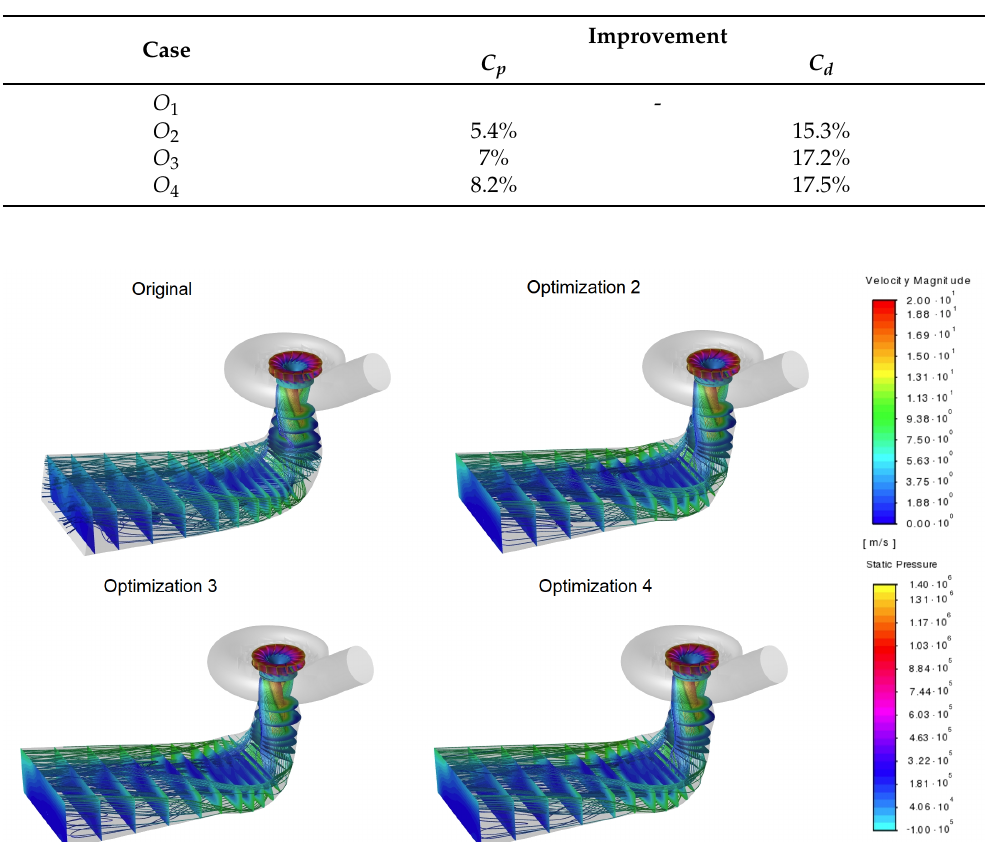
Table 8. Improvements for different optimization goal functions and bounds.